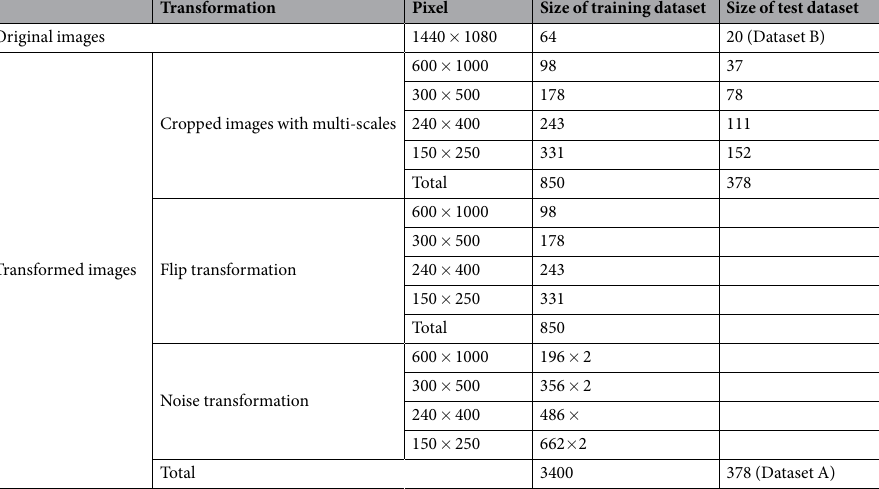
Table 1. The distribution of the training and test datasets.